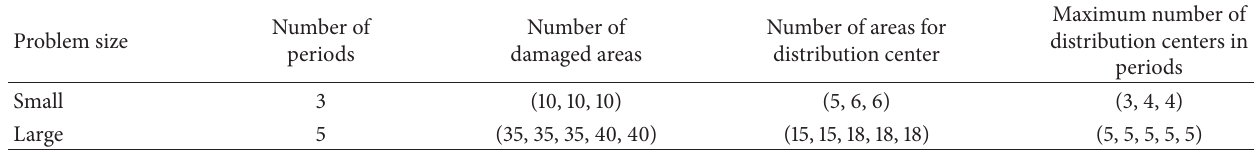
Table 5: Characteristics of sample problems that have been used for Taguchi method.